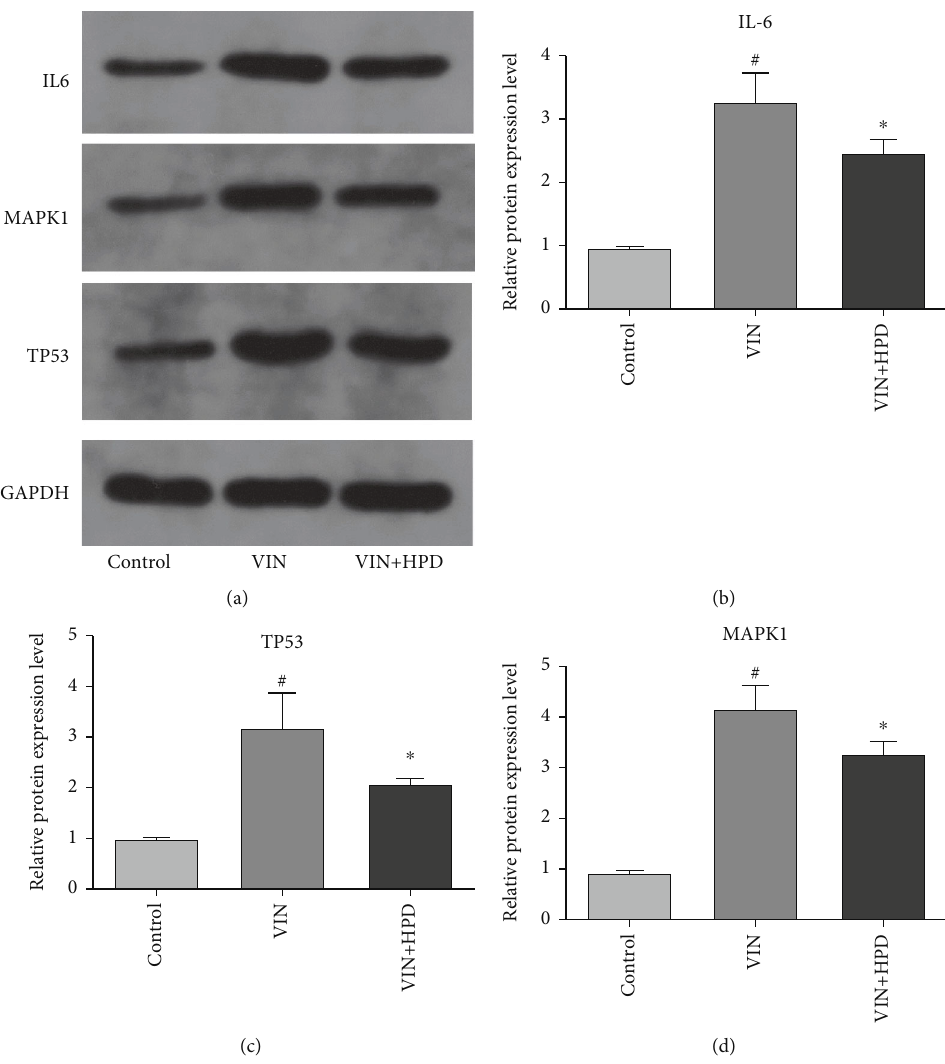
Figure 9: Validation of hub genes via western blot analyses. (a) Representative western blot analyses of IL-6, MAPK1, TP53, and GAPDH. The normalized optical density of IL-6 (b), TP53 (b), and MAPK1 (d). Results were expressed as mean ± SD ( n = 3 ). # P < 0 : 05 , the VIN group compared with the control group; ∗ P < 0 : 05 , the VIN+HPD group compared with the VIN-treated